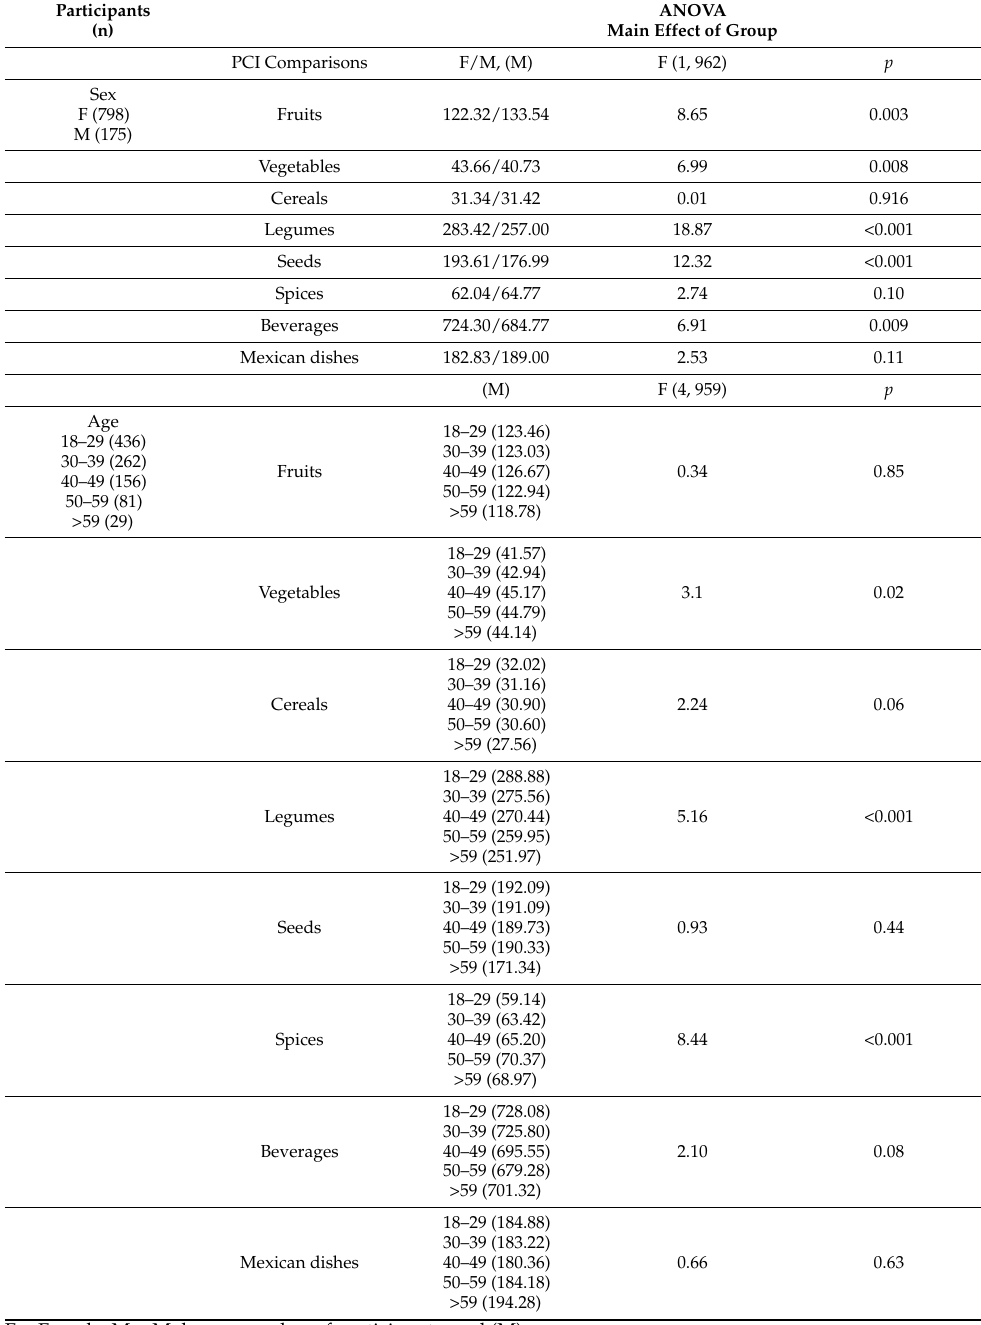
Table 4. Distribution of phenolic compounds intake by sex and